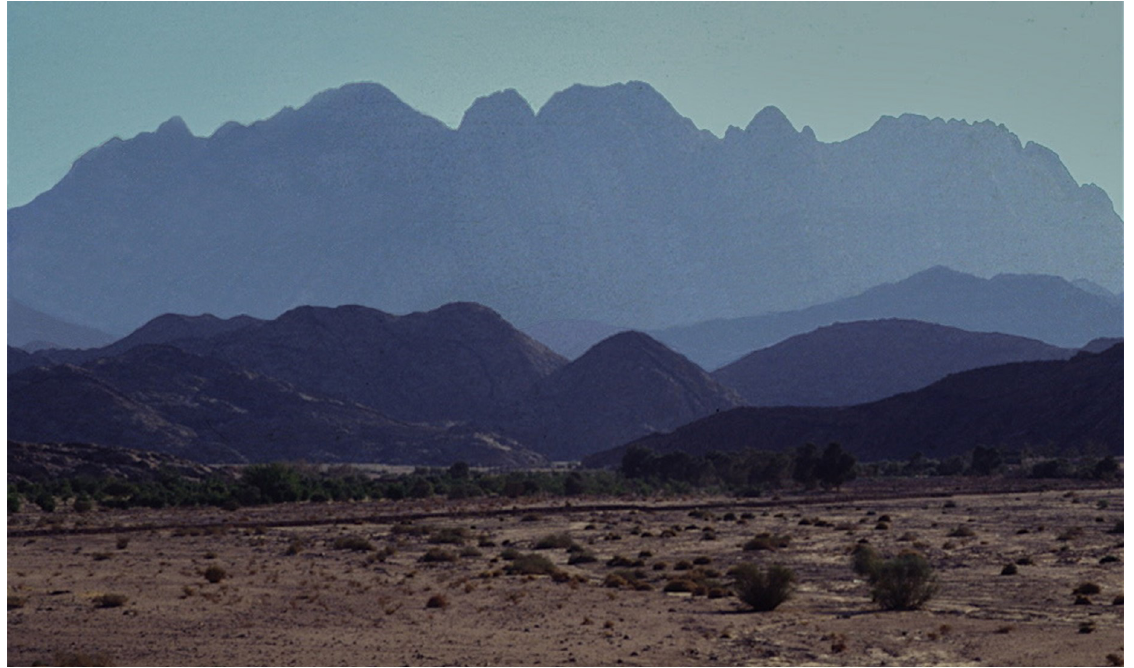
Figure 16 Jebel Serbal, looking from the eastern end of the Feiran